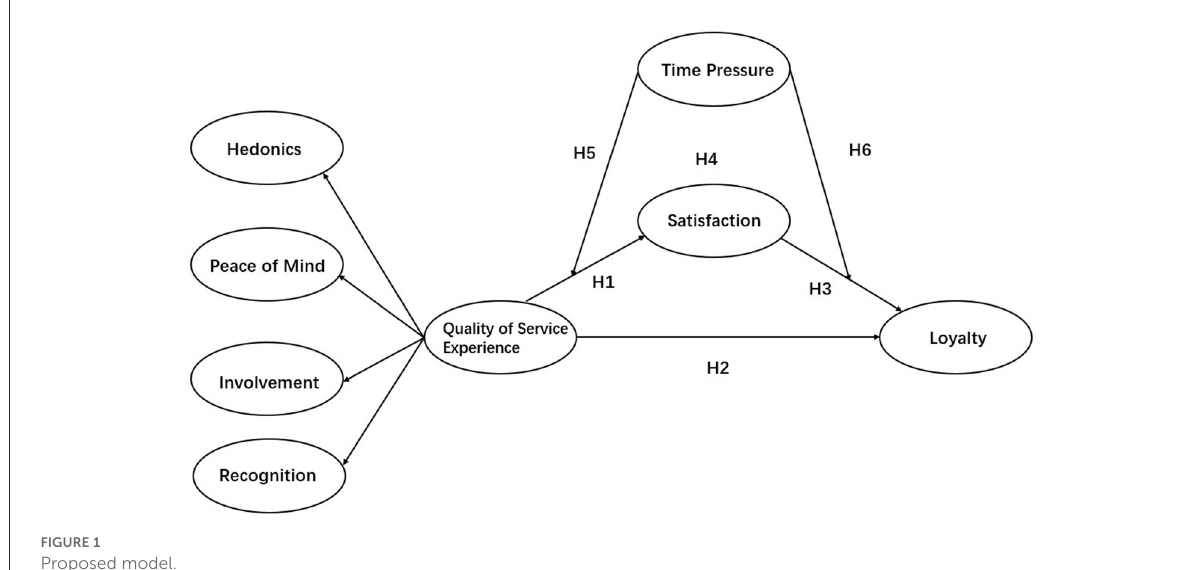
FIGURE1 Proposed